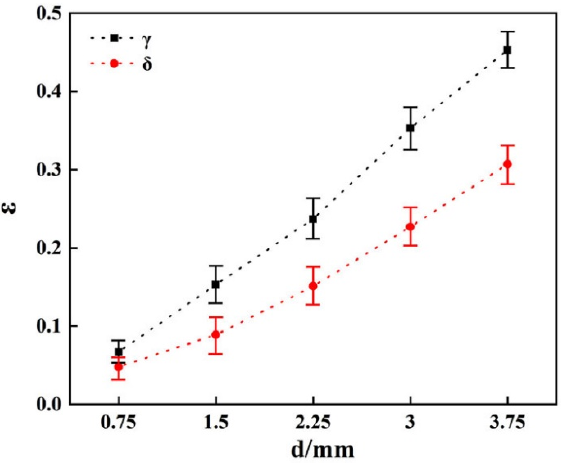
Figure 12. Relationship between the deformation and the tensile displacement of the two phases.